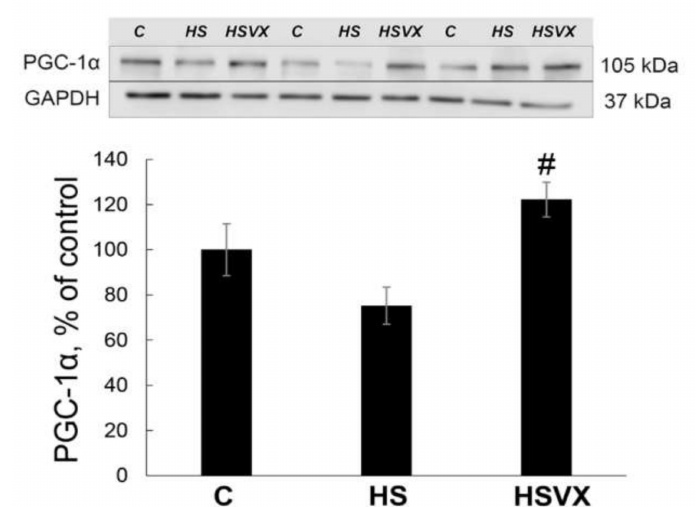
Figure 6. Evaluation of PGC-1 α protein expression in soleus muscles of C, HS, and HSVX rats by Western blotting. Values are normalized to the level of GAPDH content in each sample. n = 8. # indicates a significant di ff erence from the HS, p < 0.05.